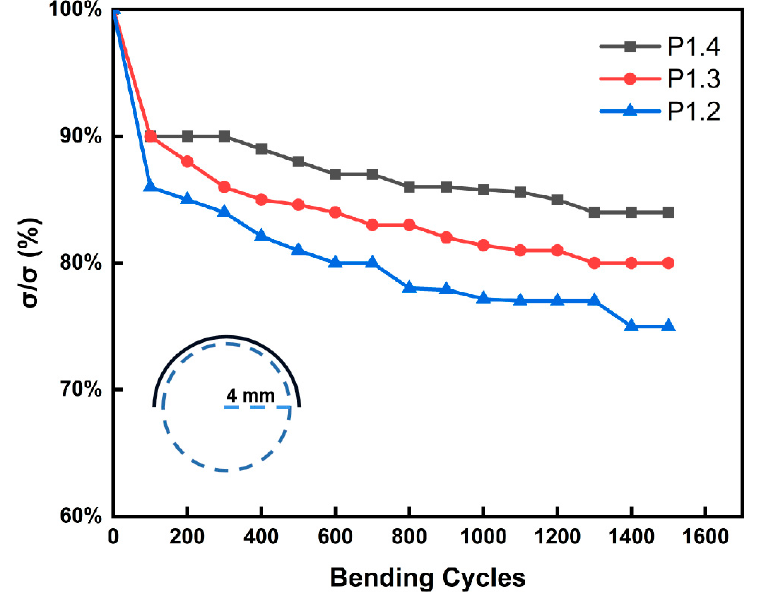
Figure 6. The flexibility of P 1.2, P1.3, and P1.4 films.